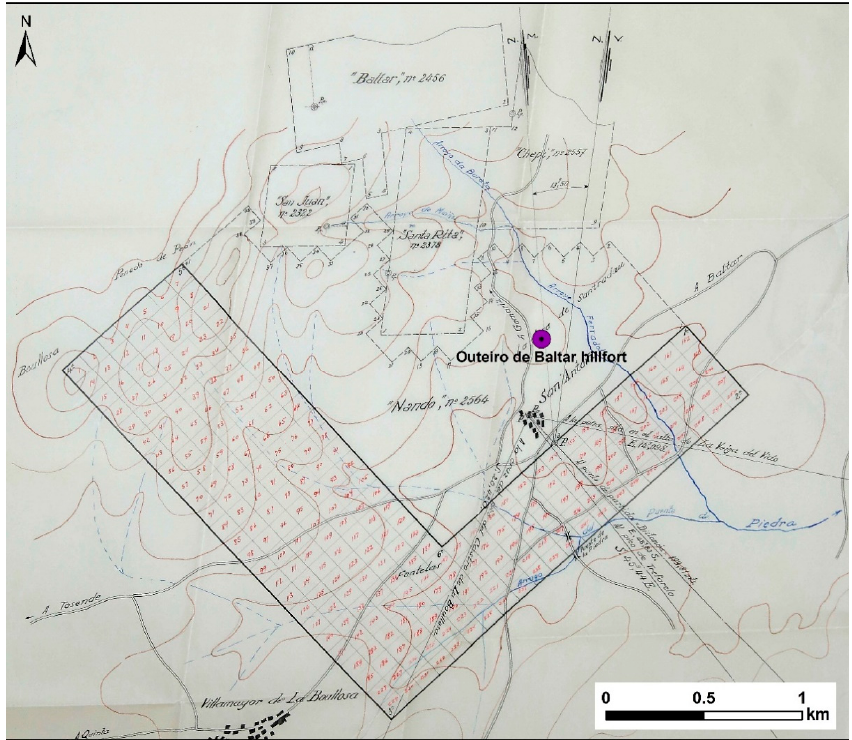
Figure 3. Map dating to 1947 of the mining concession of “Begoña” available at the Arquivo Histó- rico Provincial de Ourense that includes the mining concession of “Nando” where the Outeiro de Baltar hillfort is located. hillfort is